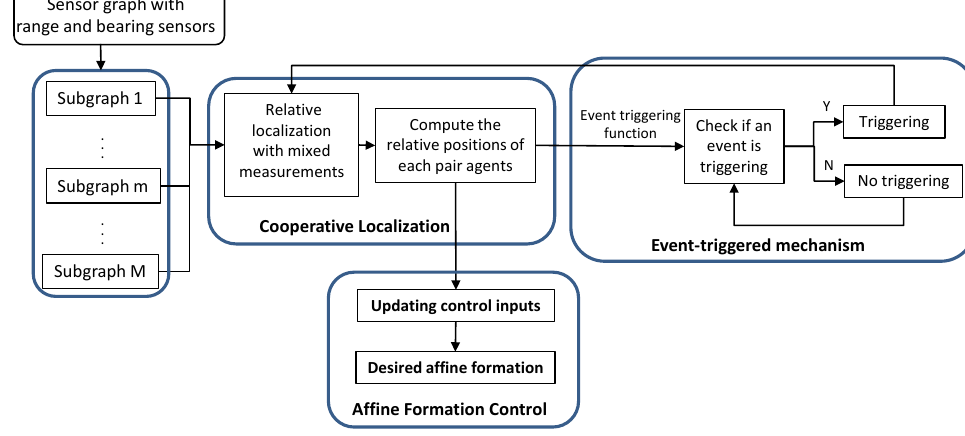
Figure 1. The block diagram and structure of distributed event-triggered formation control